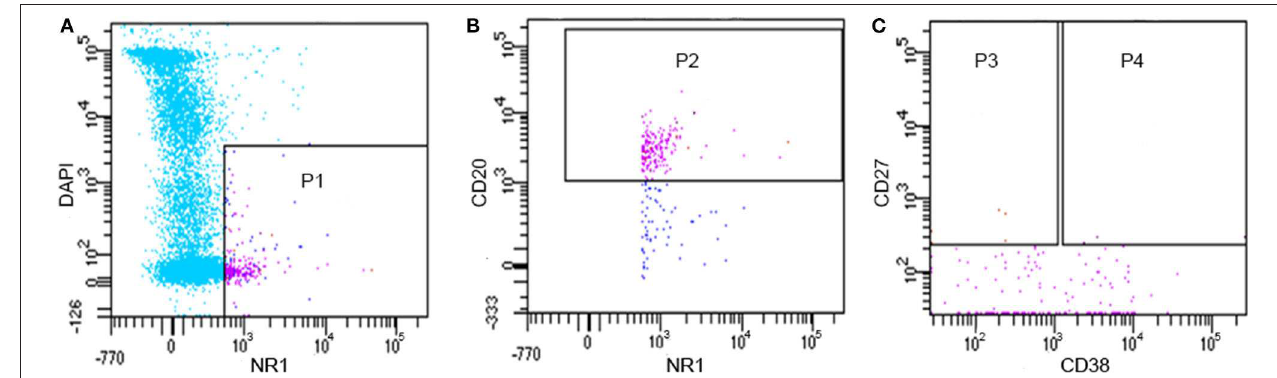
FIGURE 1 | Flow cytometry results of CD20 +NR1+B lymphocytes from one patient (PA11). (A) P1: alive NR1 positive cells; (B) P2: alive NR1 positive B cells; (C) P3: alive NR1 positive memory B cells; (C) P4: alive NR1 positive B plasmablast